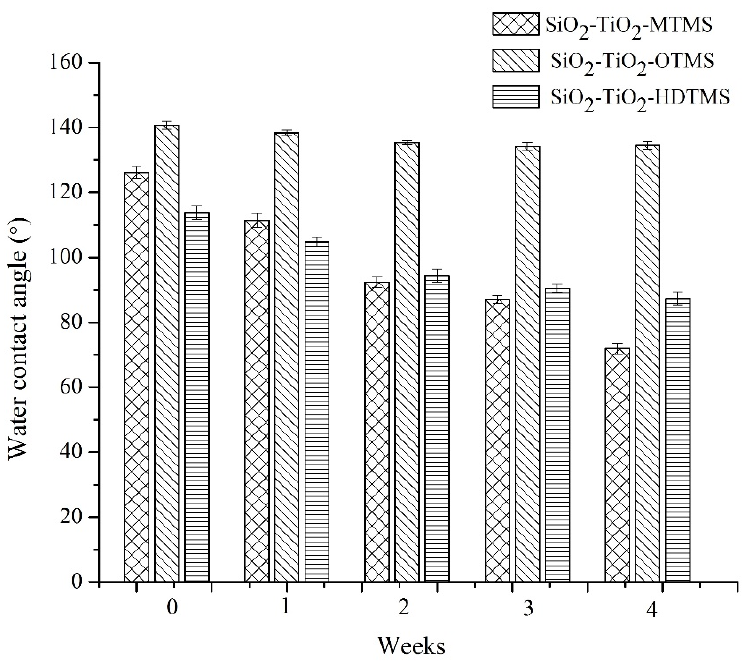
Figure 15. The change in the water contact angle of coatings undergoing outdoor exposure for four weeks.